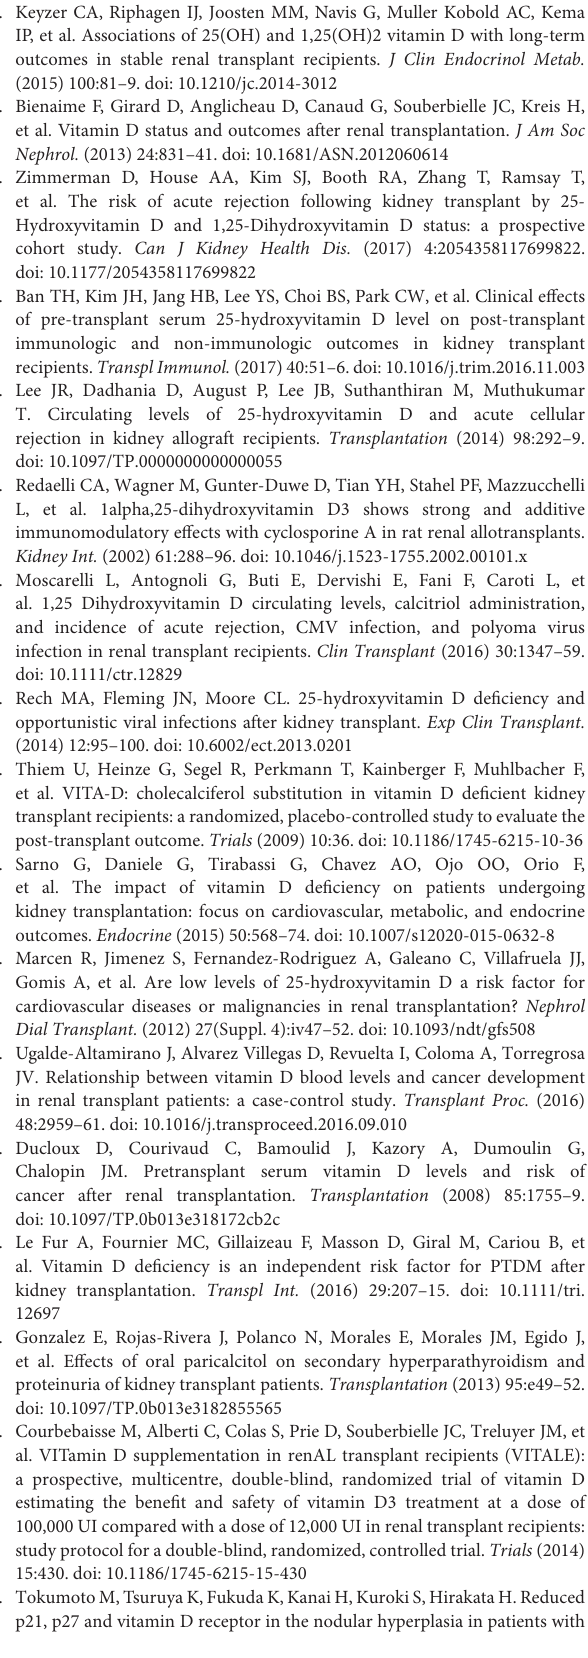
Frontiers in Medicine |